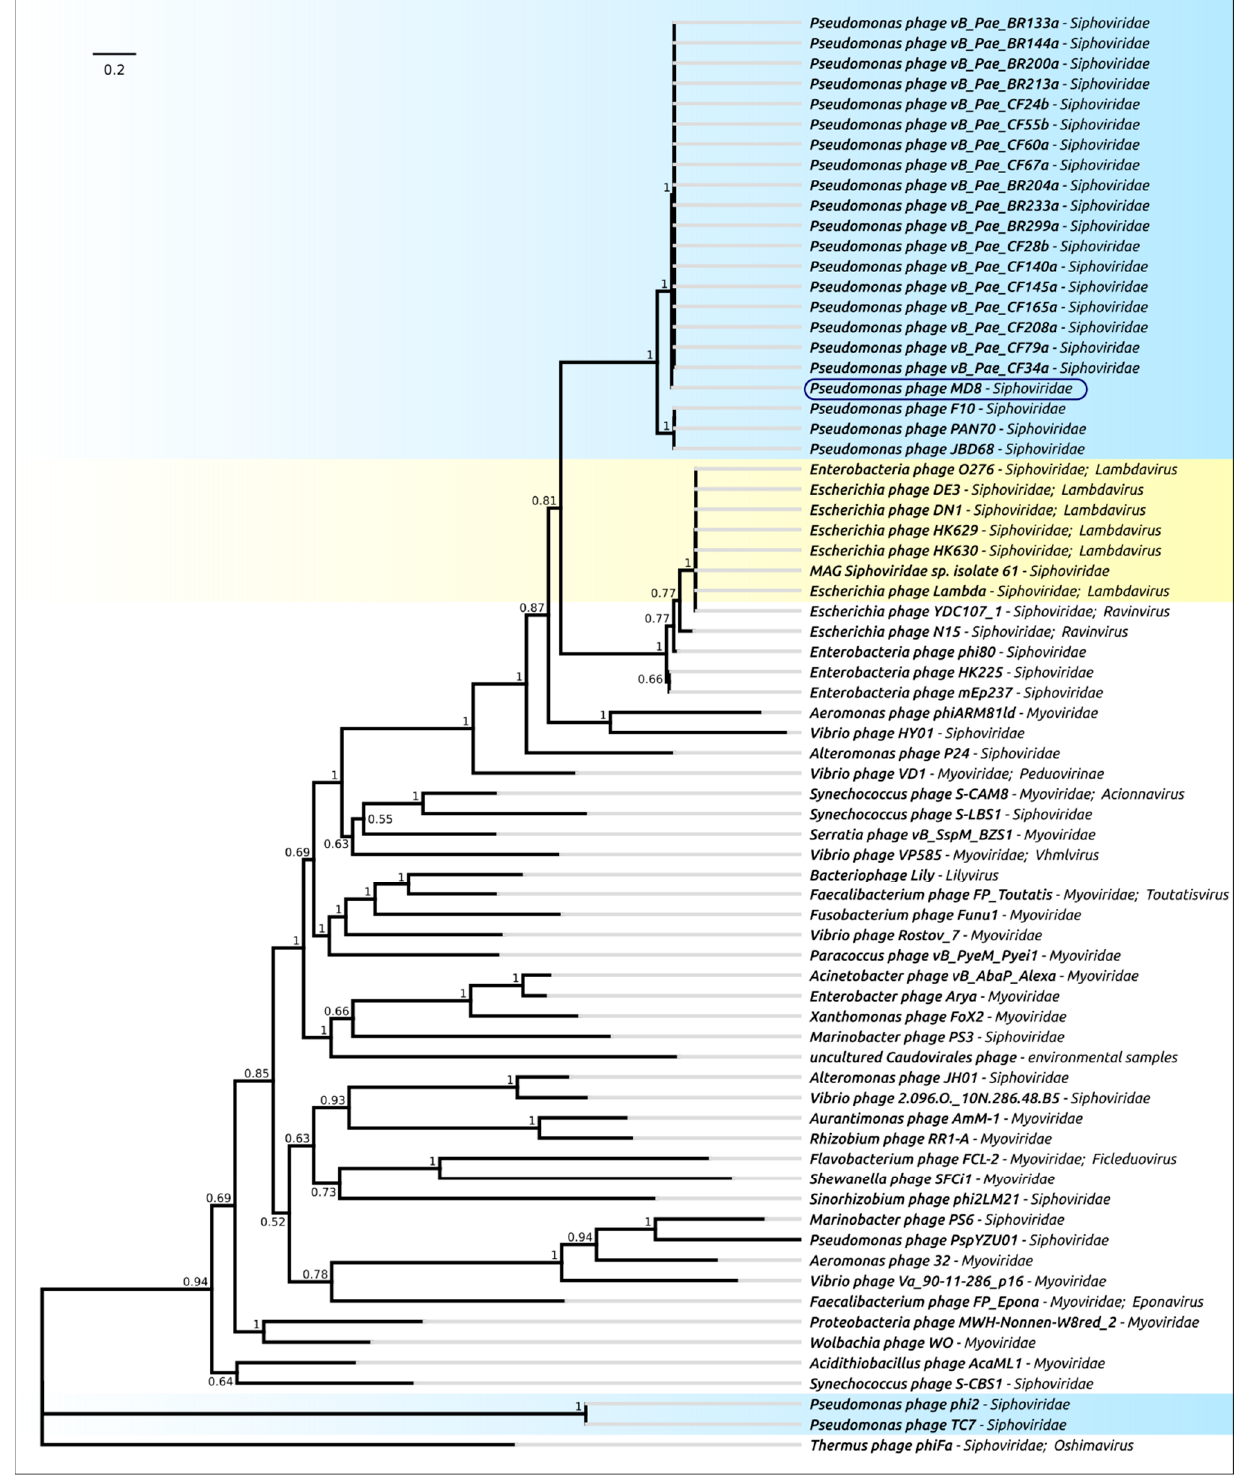
Figure 5. Phylogenetic tree obtained with MRBAYES, based on terminase large subunit amino acid sequences. Bayesian posterior probabilities are indicated near their branches. The taxonomic classification is shown to the right of the phage’s name. The scale bar shows 0.2 estimated substitutions per site and the tree was rooted to Thermus phage ϕ FA1. The chain length was 7,700,000, the burn-in length was 700,000, the subsampling frequency was 200 and the average standard deviation of split frequencies was 0.0069.